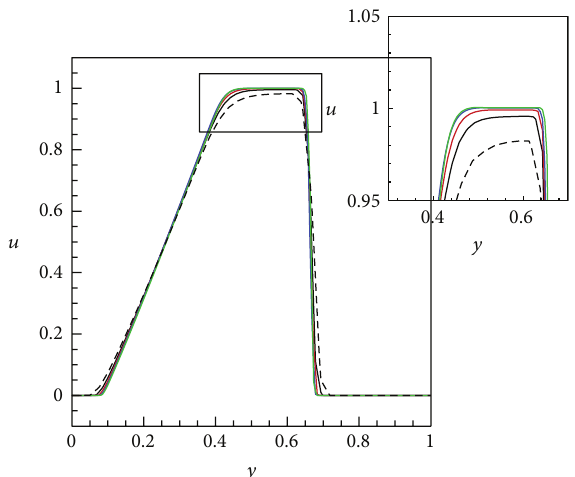
Figure 3: Instantaneous solutions, at 𝑋 = 0.5 and 𝑌 = 0.5 , of the nonlinear scalar equation (19) using the CWENO polynomial reconstruction at time 𝑡 = 0.2 for various grid resolutions. Lines: dashed black : 40 3 , solid black : 60 3 , solid red : 80 3 , solid blue : 100 3 , and solid green : 120 3 .